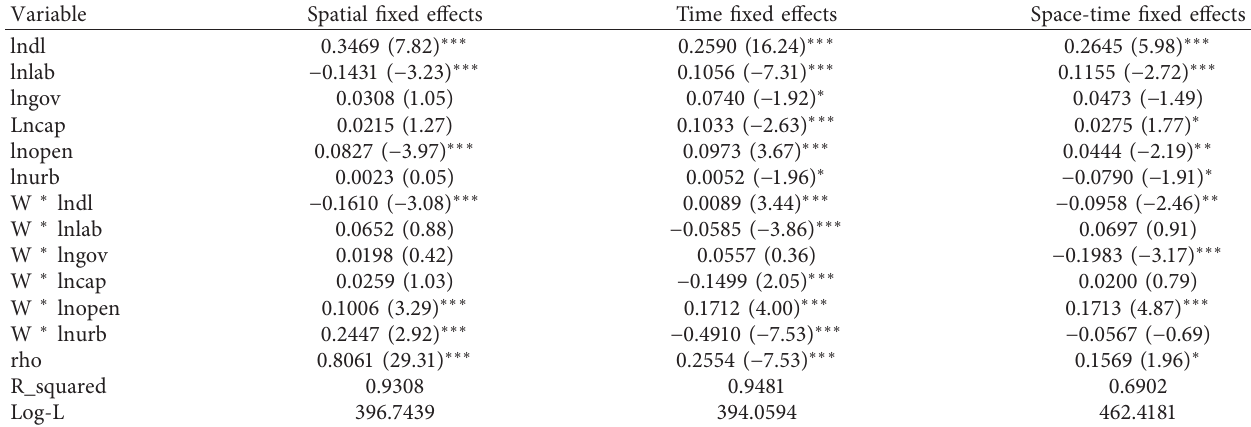
Table 6: Estimation result of the SDM.